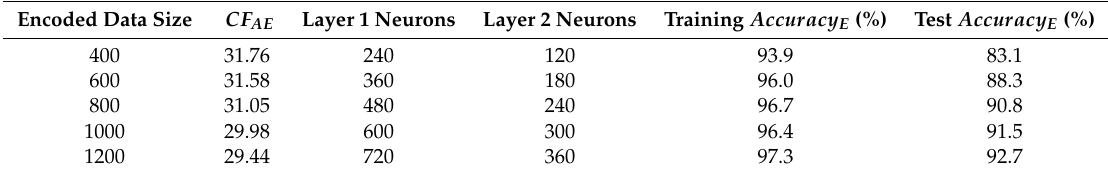
Table 5. Accuracy of the proposed load estimation ANN with varying encoded data size.